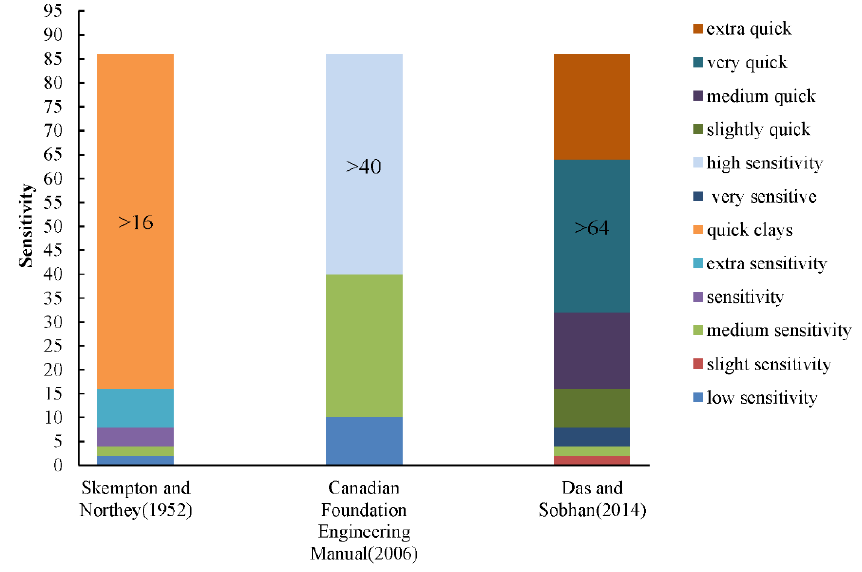
Figure 1. Different methods for clay sensitivity classification.